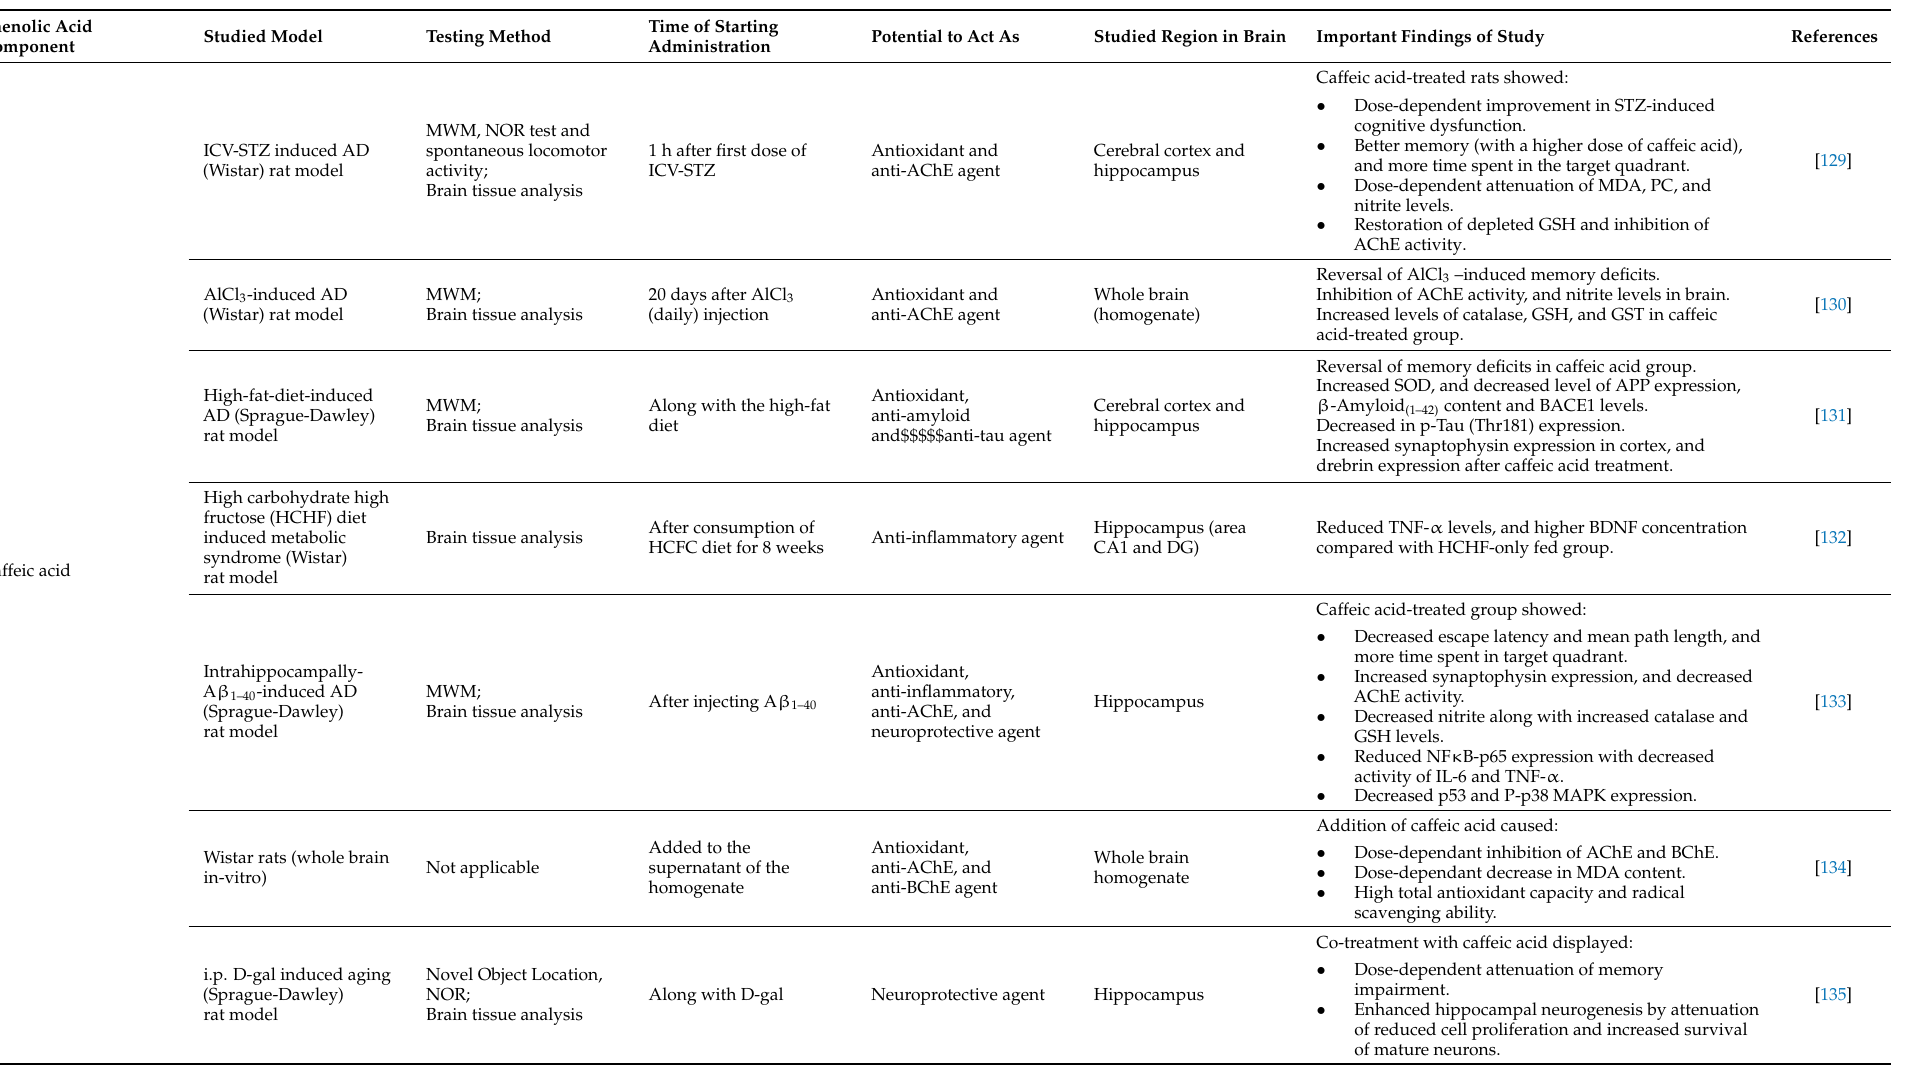
Table 2. Main phenolic acid compounds affecting the physiological functioning and/or the pathophysiology of the central nervous